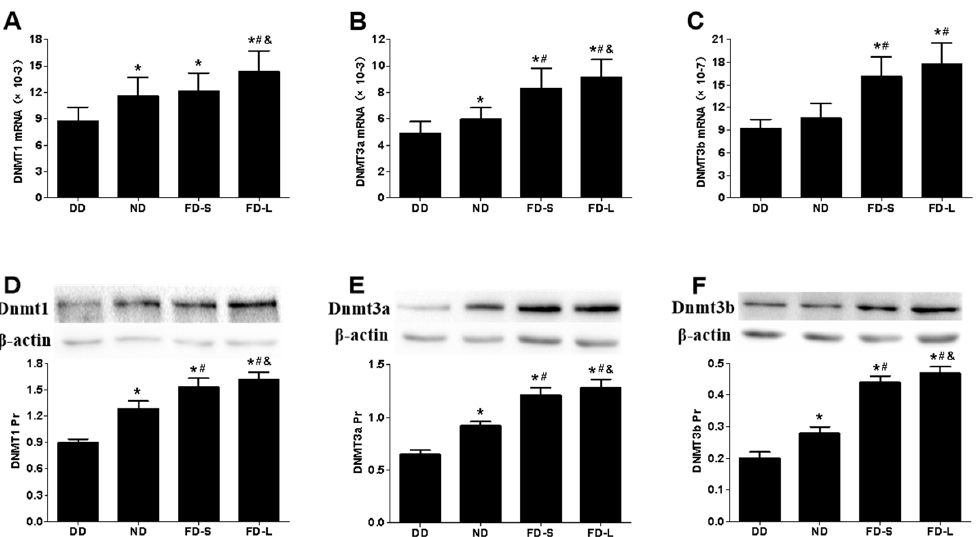
Figure 5. Maternal folic acid supplementation increased the expression of DNMTs in offspring brains. Dams were fed as described in Figure 1. ( A – C ) mRNA expression of DNMT1, 3a and 3a in brain tissue of pups; ( D – F ) Protein expression of DNMT1, 3a and 3b in brain tissue of pups. * p < 0.05 compared with DD group. # p < 0.05 compared with ND group. & p < 0.05 compared with FD-S group. Data are expressed as mean ± SD for n = 10 pups/group (same pups as Figure 2).